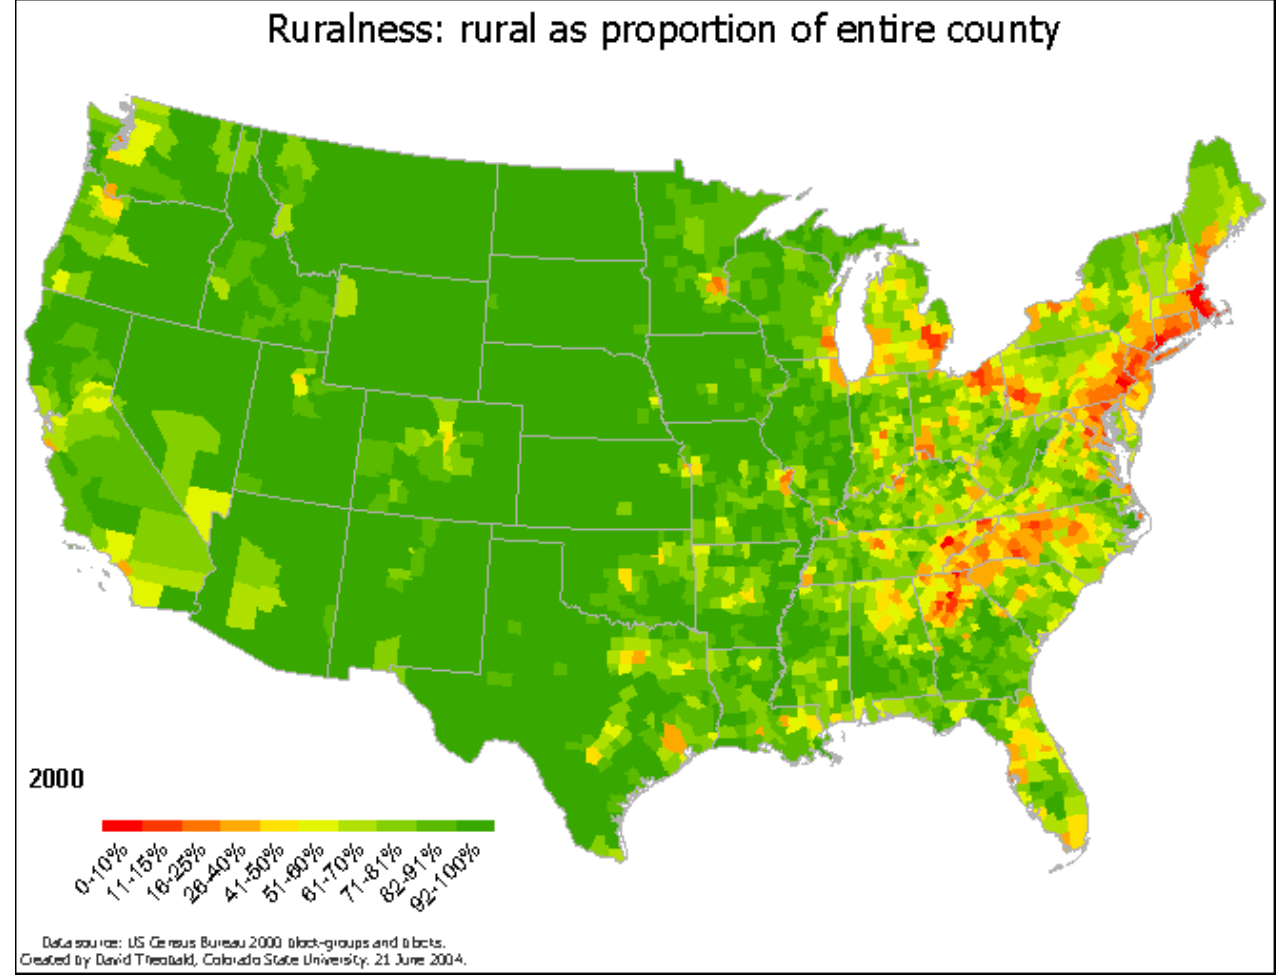
Fig. 13. A map showing the proportion of a county in rural housing density for